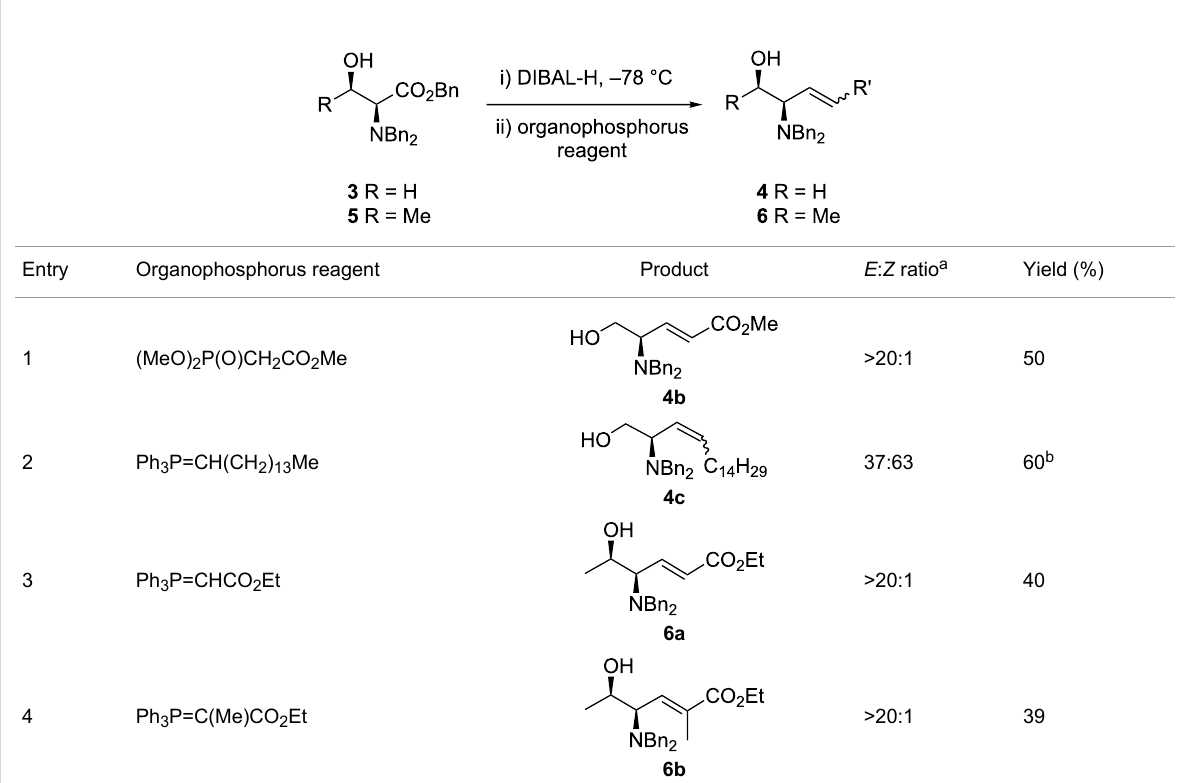
Table 4: One-pot tandem reduction–olefination of free hydroxyserine and threonine derivatives.